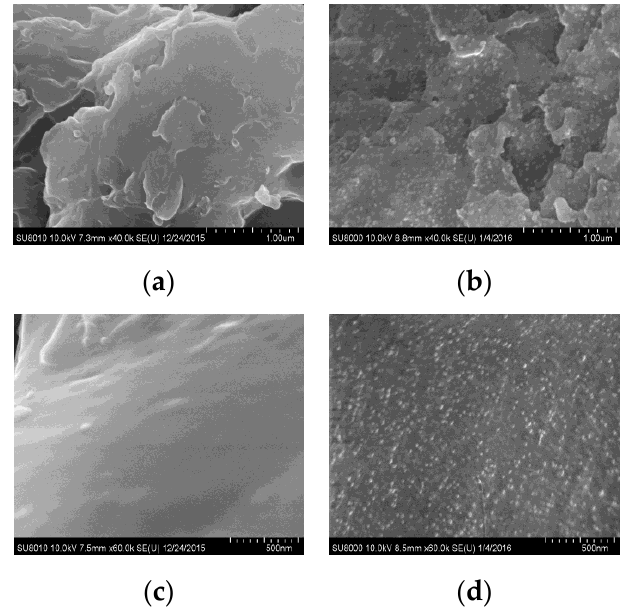
Figure 9. Field emission scanning electron microscope (FESEM) micrographs of ( a , c ) QCMC and ( b , d ) QCMC-Ag.